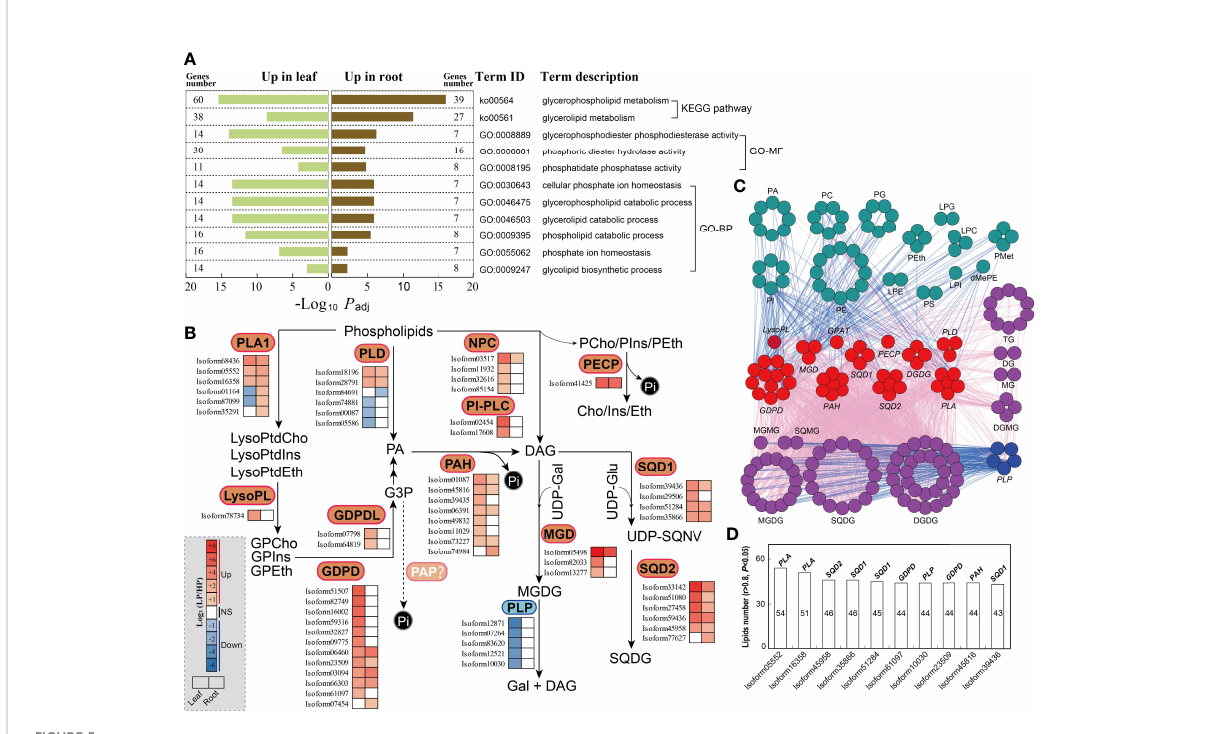
FIGURE 5 Phospholipid metabolism responding to Pi de fi ciency in elephant grass leaves and roots. (A) The signi fi cantly enriched KEGG pathways and GO categories associated with DEGs of phospholipid metabolites. (B) DEGs associated with phospholipid metabolism are shown; color intensity corresponds to expression levels standardized to log 2 (LP/HP) scales. (C) Association analysis of phospholipid metabolism DEGs and differentially expressed lipids (| r | >0.8, P < 0.05). Dark-green, purple, red, and blue circles indicate decreased and increased lipids and up-regulated and down- regulated unigenes, respectively. Blue and pink lines indicate negative ( r < – 0.8, P < 0.05) and positive ( r > 0.8, P < 0.05) correlation, respectively. (D) The top 10 unigenes most correlated with lipids (data based on Figure 5C). PLA1, phospholipase A1; LysoPL, lysophospholipase; GDPD, glycerophosphodiester phosphodiesterase; GDPDL, glycerophosphodiester phosphodiesterase-like; PLD, phospholipase D; PAH, phosphatidate phosphatase; NPC, non-speci fi c phospholipase C; PI-PLC, phosphoinositide phospholipase C; PECP, phosphoethanolamine/phosphocholine phosphatase; MGD, monogalactosyl diacylglycerol synthase; SQD1, sulfoquinovosyldiacylglycerol 1; SQD2, sulfoquinovosyldiacylglycerol